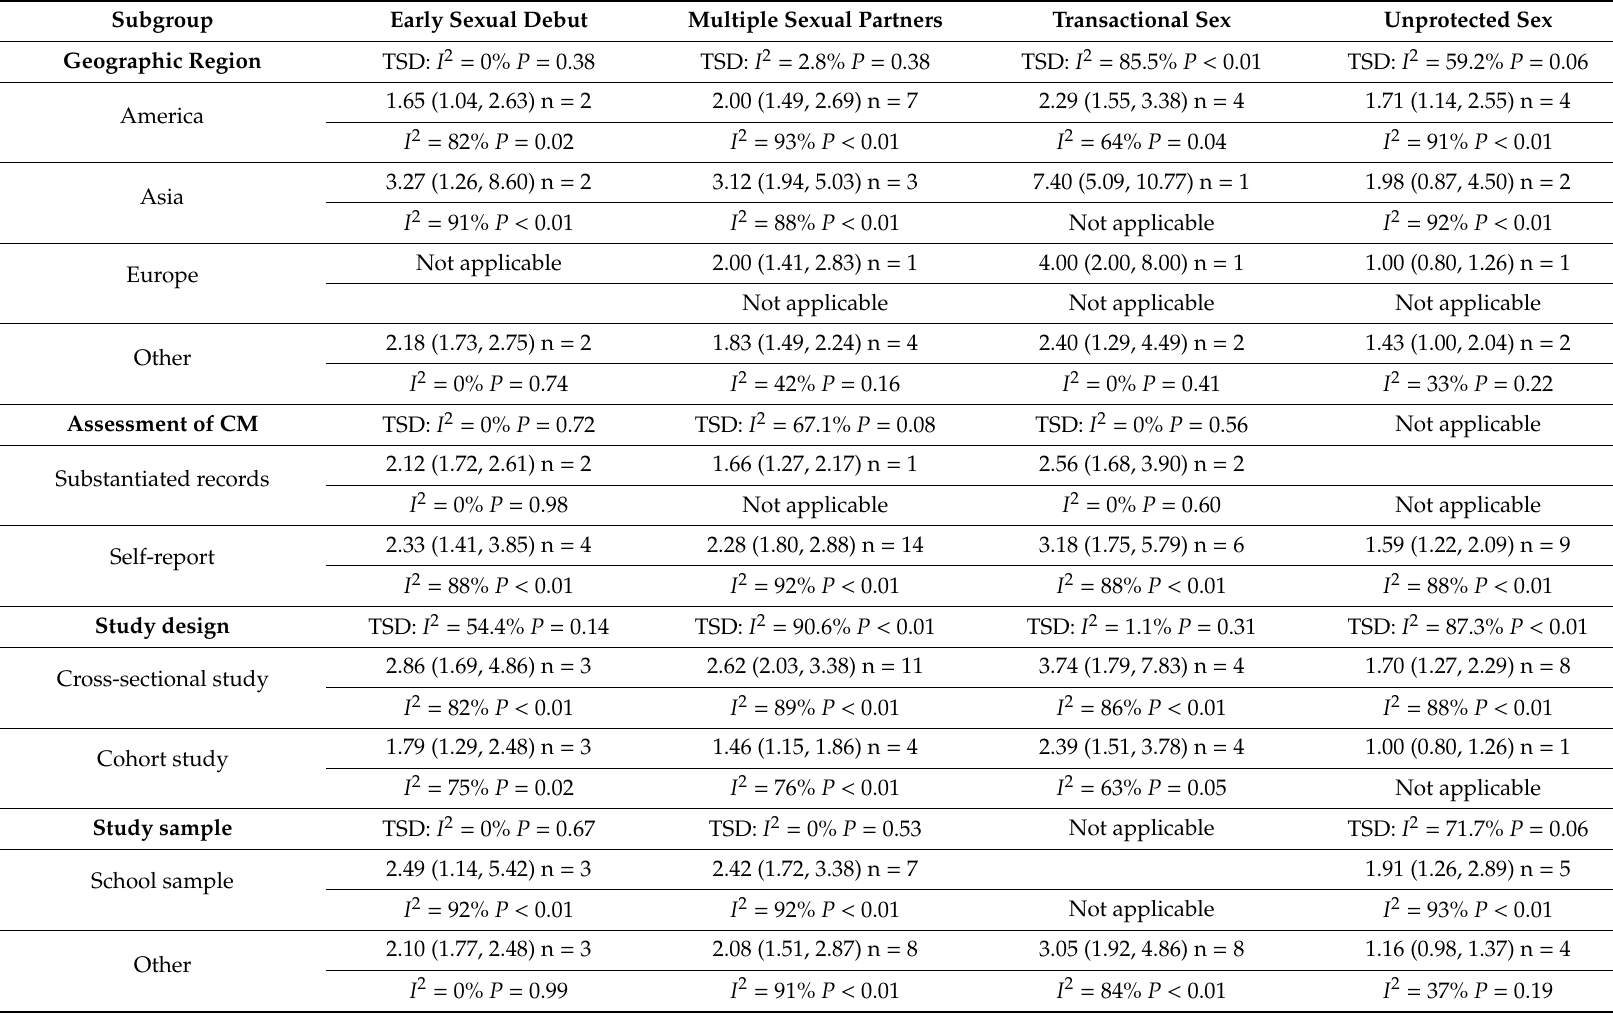
Table 2. Subgroup analysis of association between childhood maltreatment and risky sexual